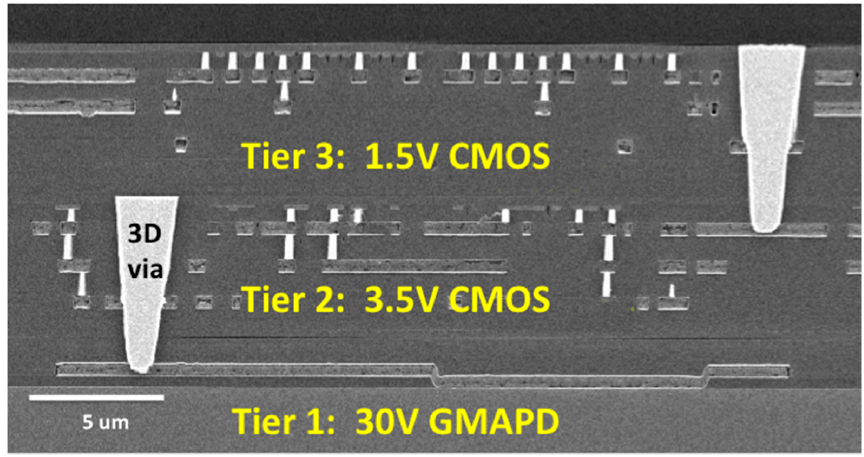
Figure 5. Cross-sectional SEM through a pixel of the 64×64 GMAPD array.